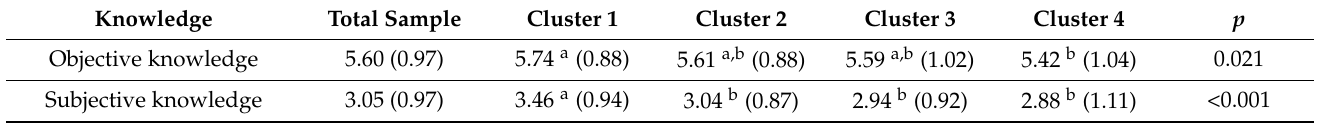
Table 6. Knowledge about fish of Croatian fishery consumers (n =